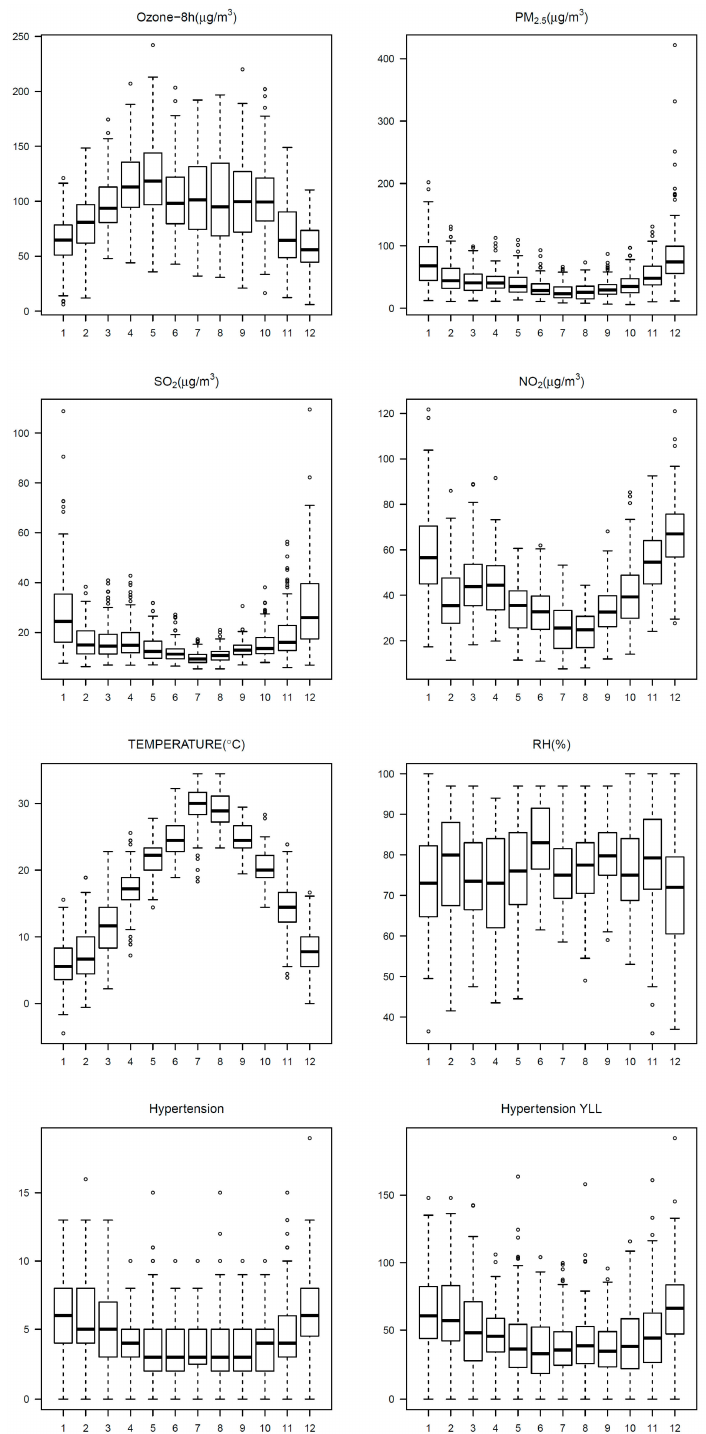
Figure 1. Box plots of monthly air pollutant concentrations, meteorological conditions, number of deaths, and the corresponding years of life lost (YLL) from hypertension in Ningbo, China, from 2013 to